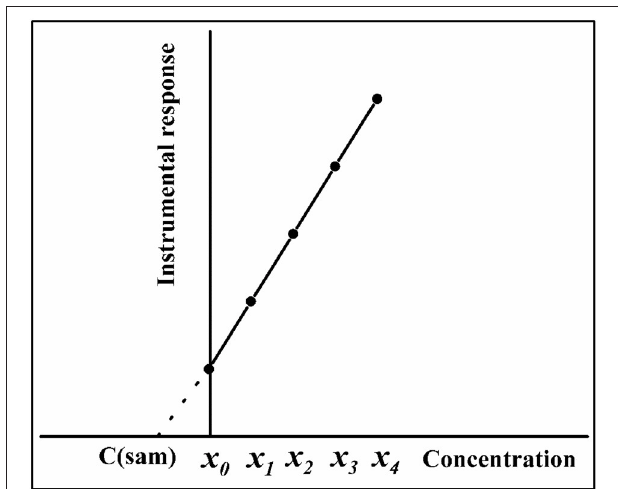
FIGURE 1 | SA calibration plot using four addition points ( x 1 - x 4 ). Extrapolation is represented by a broken line, and x 0 is the sample with no standard addition.